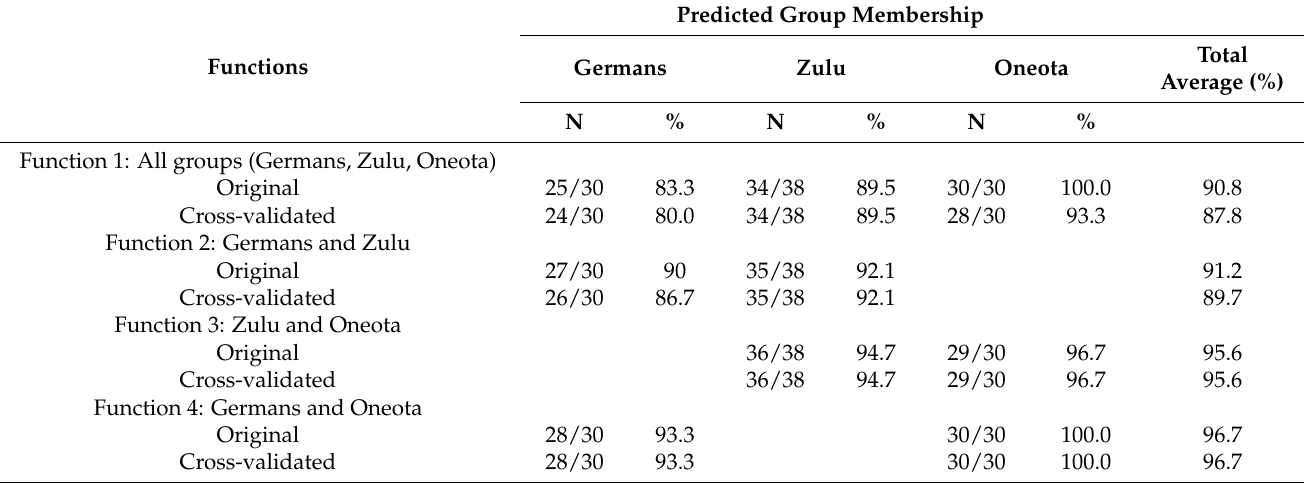
Table 4. Accuracy of classification results of the original and cross-validated 1